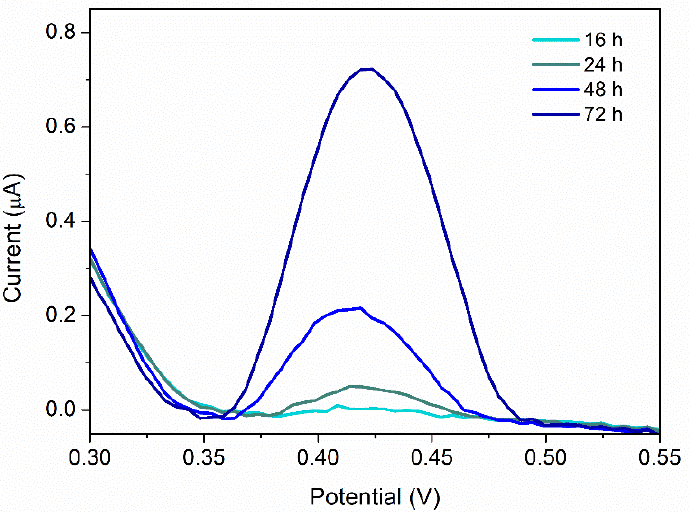
Figure 10. DPV analysis of P. aeruginosa cultures (dilution NB:H 2 SO 4 1:10) at different moments in their growth (the results for the clinical isolate).